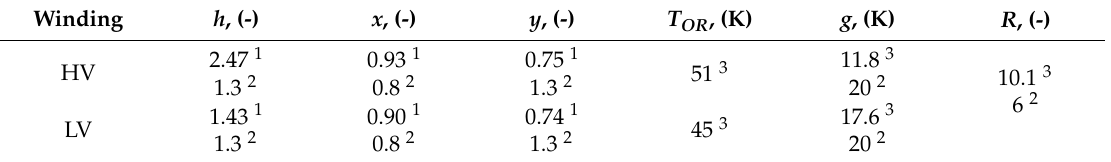
Table 1. Input parameters of the IEC model for the exemplary unit